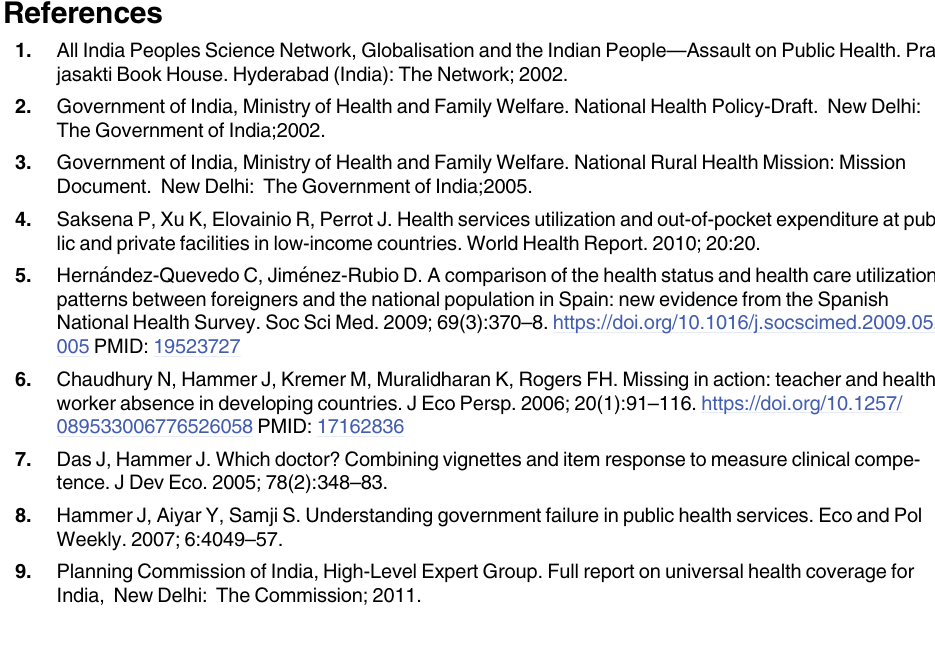
S5 Table. States wise variation for unmet need for treatment seeking from any sources among those who have not seeking treatment from any sources by major diseases condi- tions in India, NSS 2004–2018,